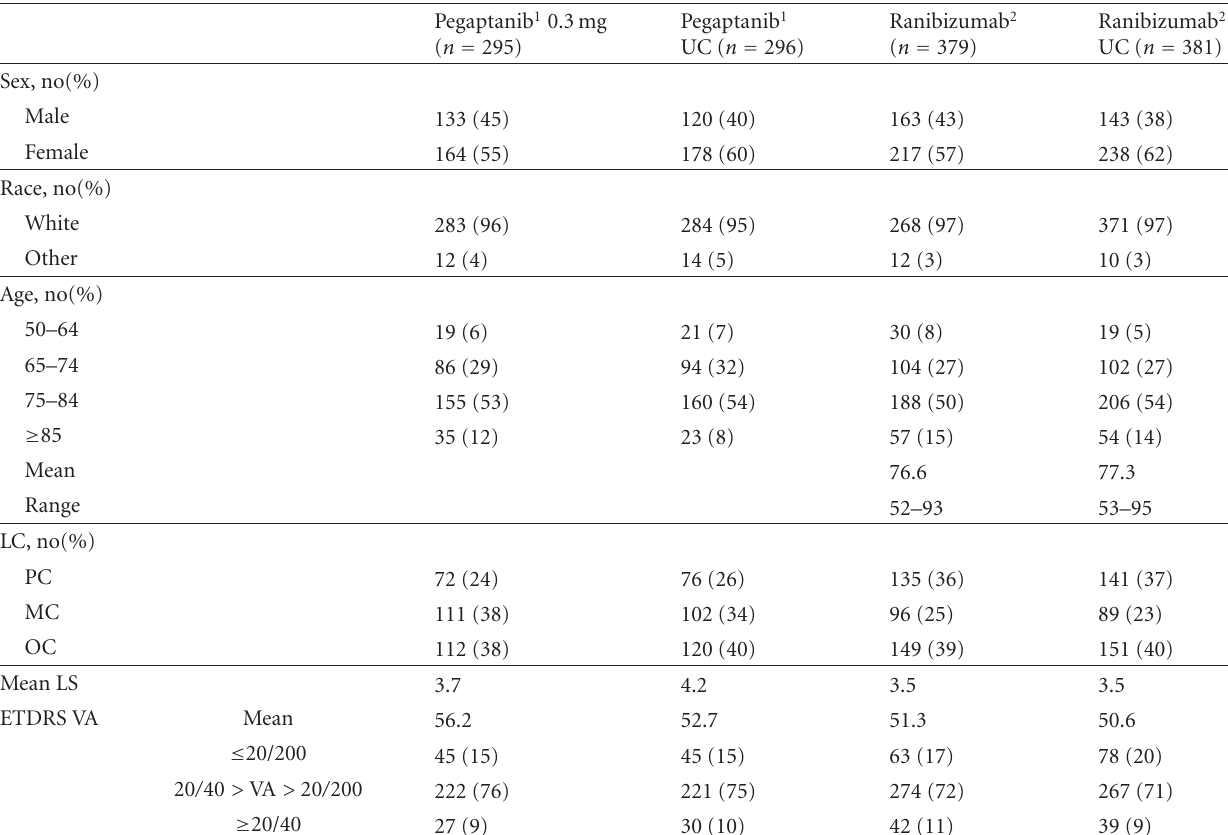
Table 6: Characteristics of study populations at